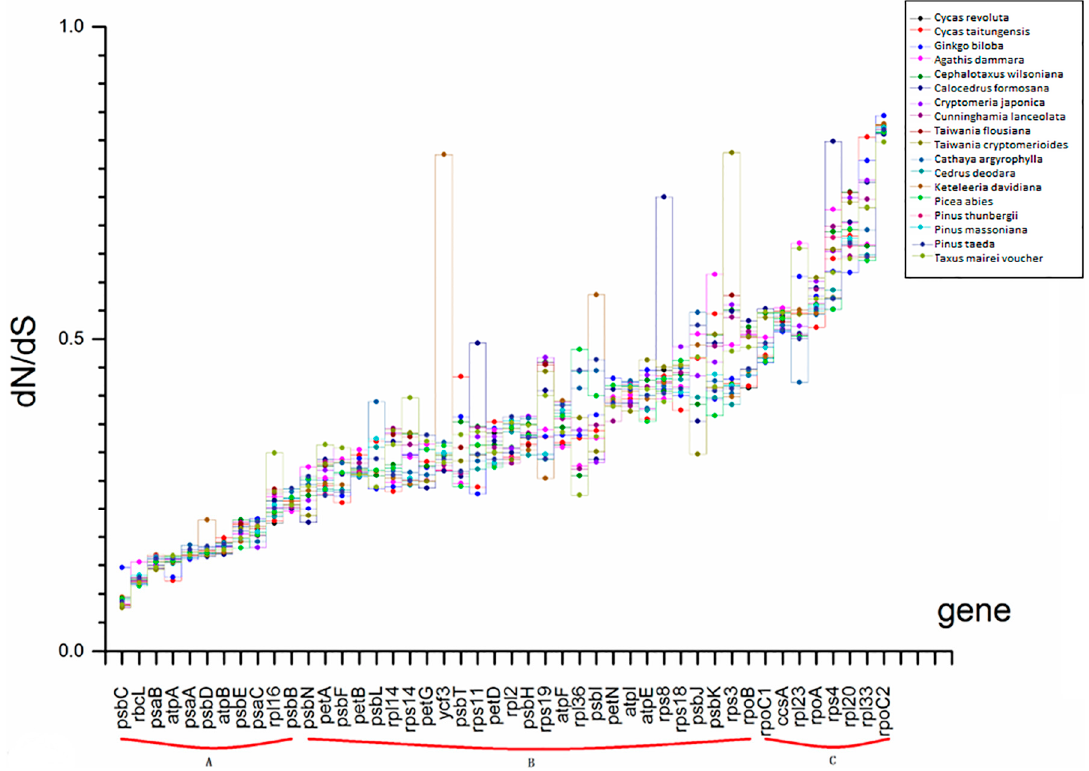
Figure 3. Comparison of the selection forces (dN/dS) of the 46 common protein-coding genes in the 19-species matrix. The matrix consisted of 19 species including Selaginella moellendorffii and 18 gymnosperms. A, B and C represent different dN/dS ranges groups according to the description in Section 3.6.